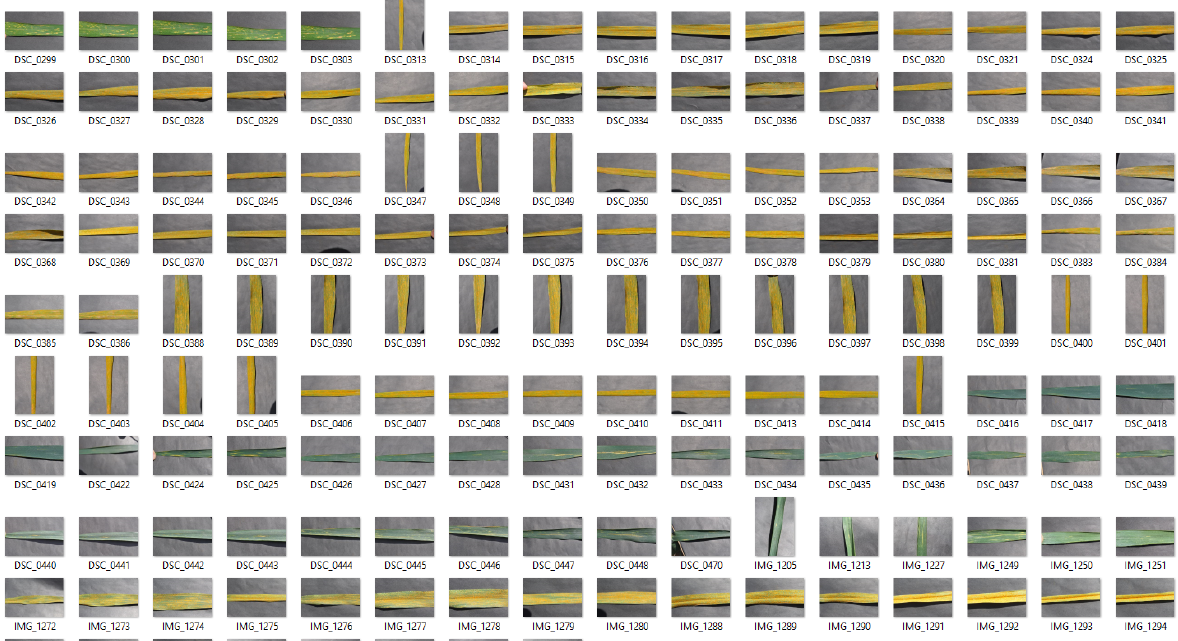
Figure 4. Portion of acquired dataset representing wheat rust infection